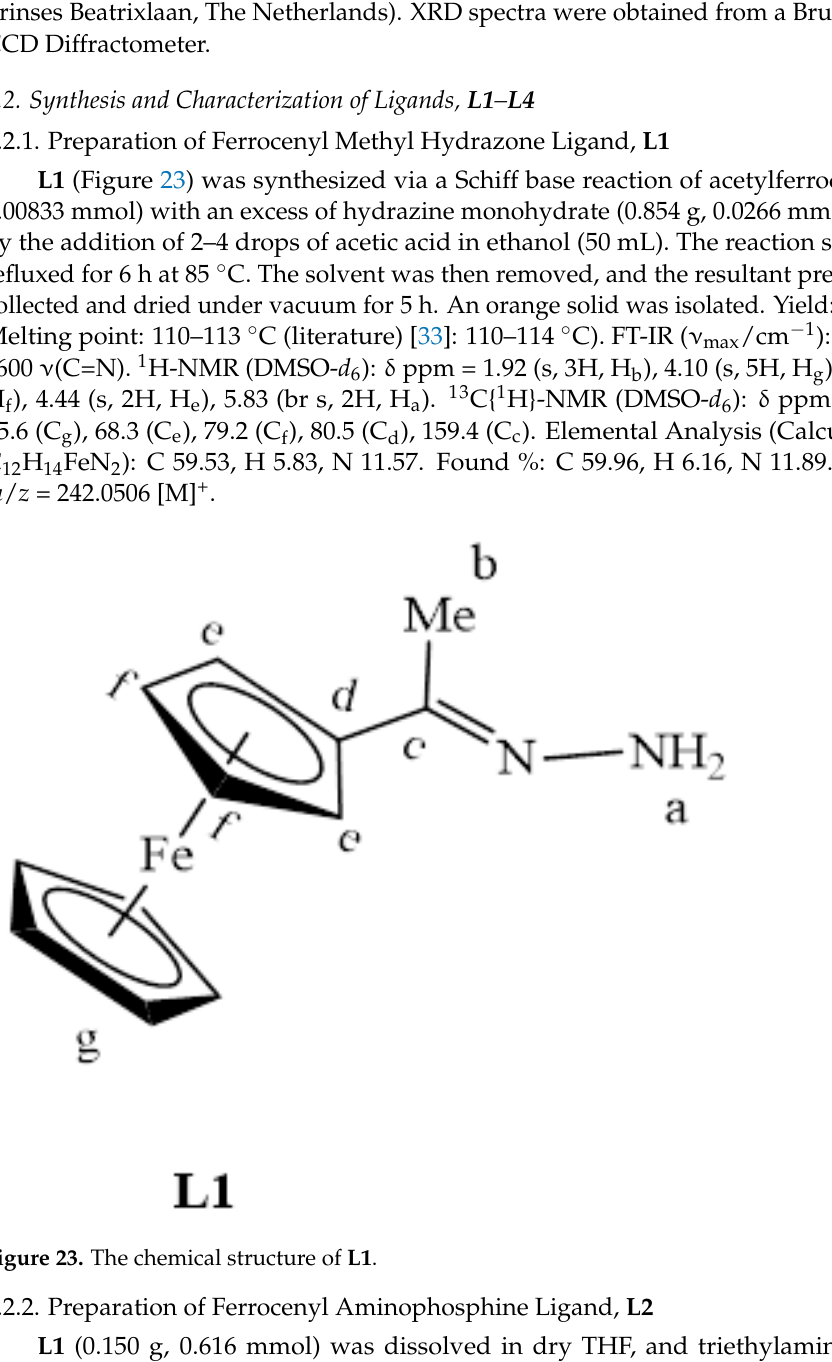
Figure 23. The chemical structure of L1